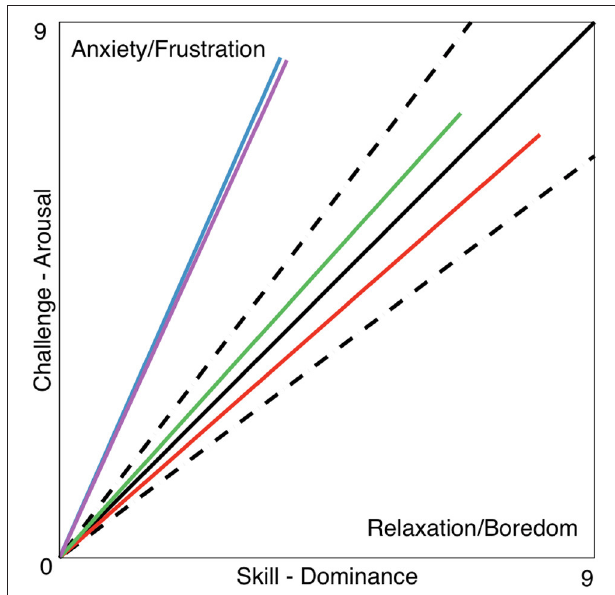
FIGURE 7 | Vector representation of the challenge/skill relation for the CT _HDM (solid blue line) and HDM (solid red line) tasks. The data for CT_HAO (solid purple) and HAO (solid green) tasks are also shown. The dotted lines delimit the flow channel, i.e., the range reflecting an ideal challenge/skill ratio, and the solid black line represents the maximal challenge/skill ratio F = [9,9]. The presented data is taken from Table 5 .